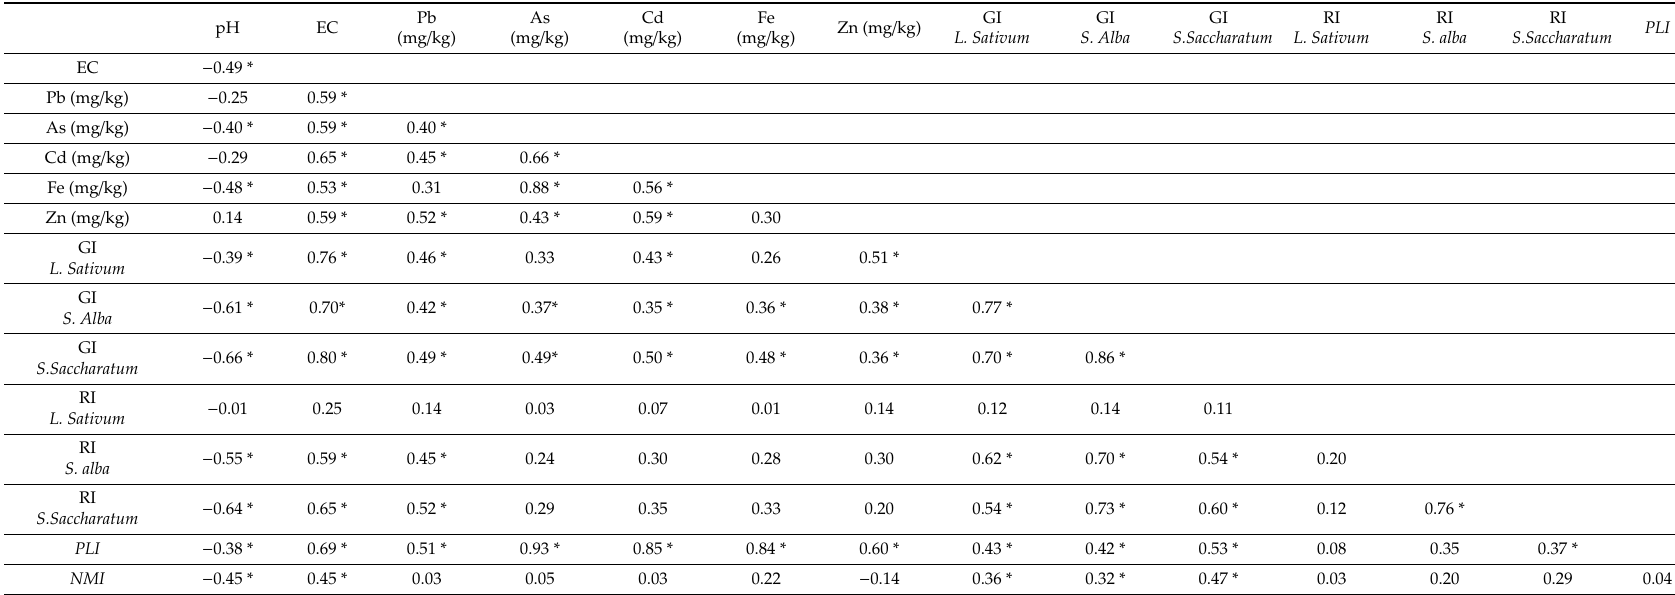
Table 6. Correlation analysis